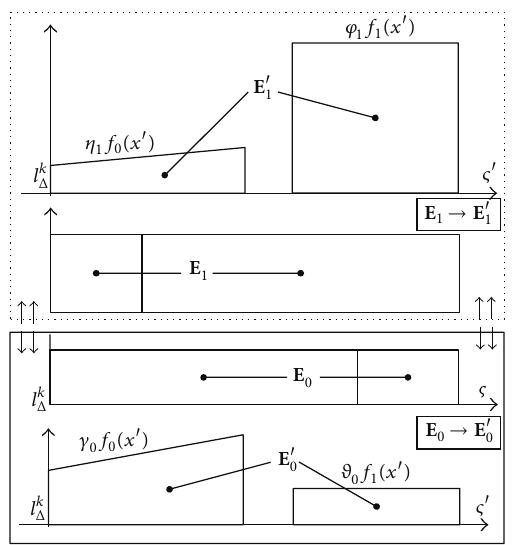
Figure 4: Scheme of redistribution of original samples during quantization, Ω is